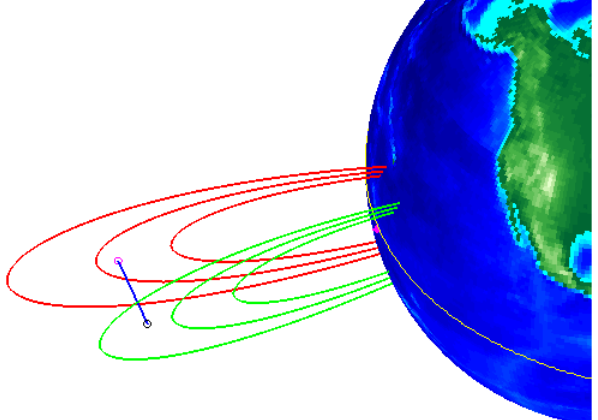
Fig. 1. The geometry of the VHF scintillation observations. Ma- genta circle shows the IPP (1.70 ◦ S, 199.0 ◦ E) of the west-looking VHF signal monitor in a magnetic flux-tube context (field lines are shown as red and green, and were derived from the IGRF 11 model). The black circle shows IPP (1.75 ◦ S, 208 ◦ E) of the east-looking monitor. The magnetic equator is shown by yellow line. The ma- genta star near the magnetic equator on the ground shows the loca- tion of the